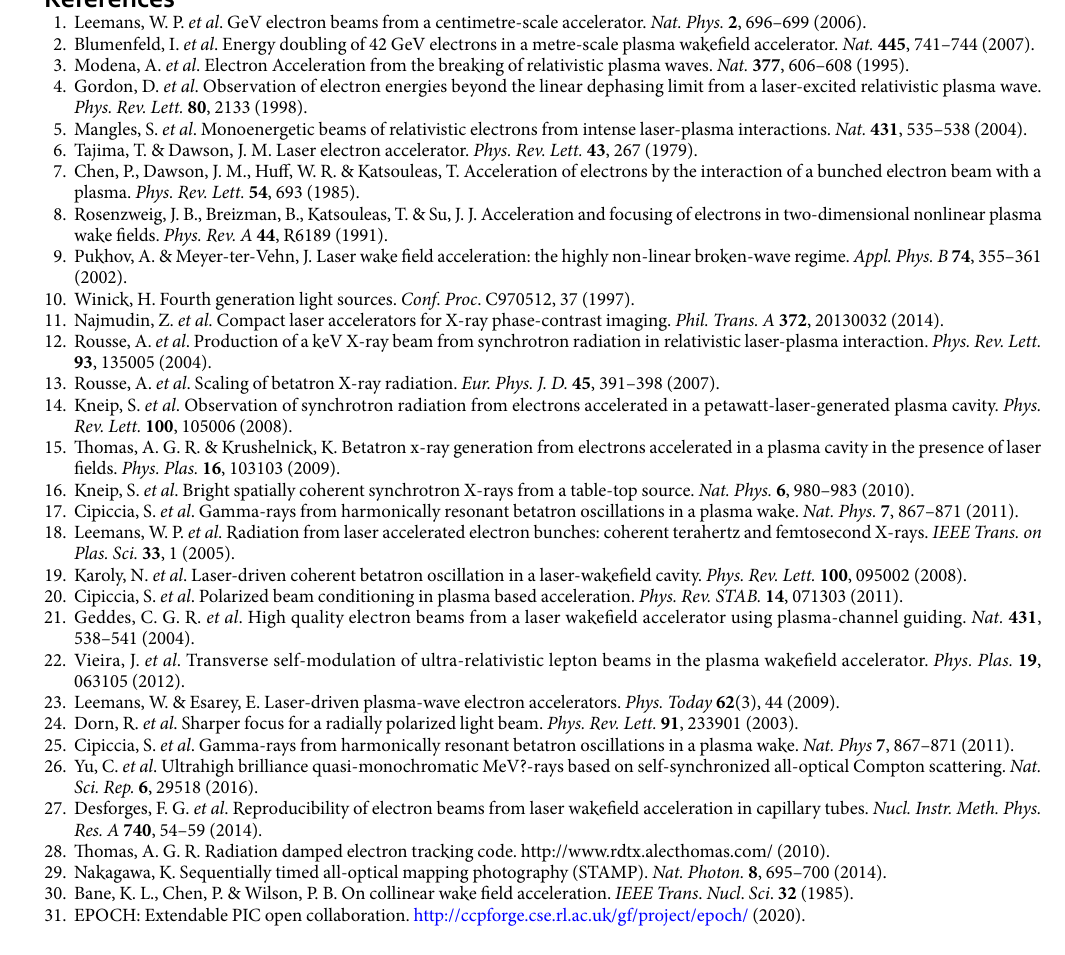
Figure 4 plots the peak brilliance of the single representative micro-bunch against existing third generation light sources. The peak brilliance of the micro-bunch is found using equation 7. There is a three order of magnitude enhancement to peak brilliance when compared to the third generation light sources which extends well into the hard X-ray regime. Broadband emission is seen and there are no characteristic narrow energy bands, as would be expected from an undulator. In contrast to betatron oscillations that arise from electrons injected in the blow-out laser wakefield regime (comprising typically of tens of pico-coulombs of charge oscillating over millimetres), a nano-coulomb of charge in the micro-bunches undergo these coherent oscillations over tens of centimetres. Note that, since the peak brilliance of a synchrotron-like source is proportional to the charge of the beam and inversely proportional to the length of the beam, the peak brilliance of the micro-bunch train will be comparable to the single representative